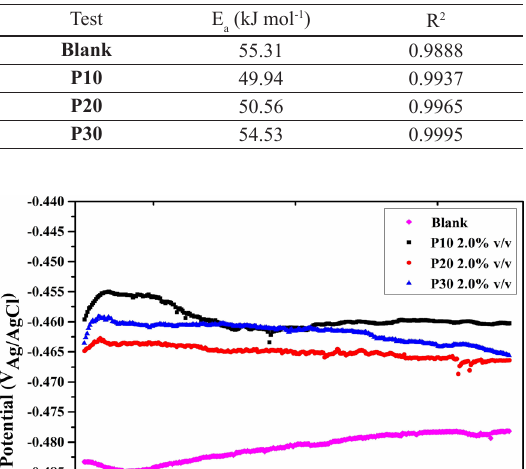
values for API P110 carbon steel in 1 M HCl for the Table 4. E a inhibited and non-inhibited systems (3.5% (v/v)).